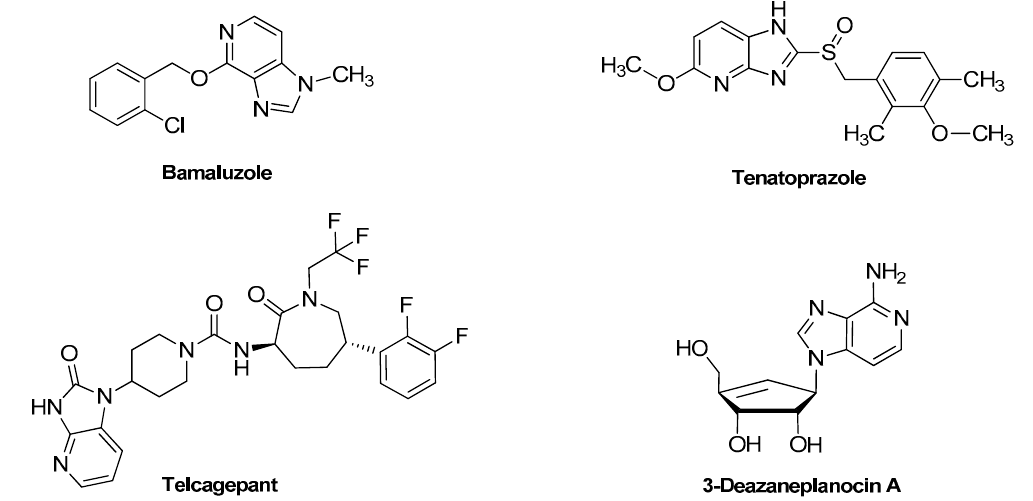
Figure 2. Examples of bioactive agents possessing imidazo[4,5- b ]pyridine or imidazo[4,5- c ]pyridine cores.